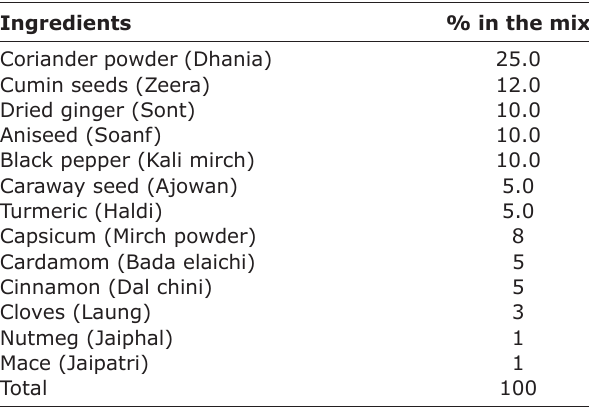
Table-1: Composition of spice mix for meat spread. Ingredients